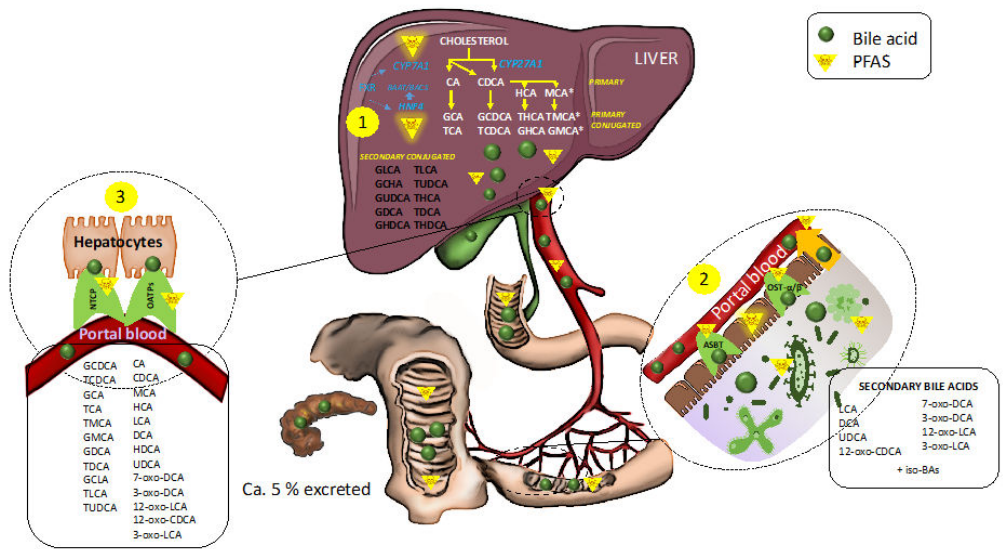
Figure 3. Bile acid biosynthesis and enterohepatic circulation, and the impact of polyfluoroalkyl substances (PFASs) on bile acid (BA) metabolism. (1) In the liver, the classic BA synthesis pathway is initiated by cholesterol 7 α -hydroxylase (CYP7A1) which is downregulated by PFAS. The alternative BA synthesis pathway is initiated by CYP27A1 to synthesize primary bile acids, CA and CDCA, in hepatocytes. CDCA can be further converted to HCA and MCA in the liver. CYP7A1 is downregulated by PFAS. Bile acids are conjugated to the amino acids taurine or glycine before being released into the intestine. HNF4 α , which plays a central role in bile acid conjugation by direct regulation of VLACSR and BAAT, can be suppressed by PFAS. (2) BAs are recovered into portal blood through a combination of passive absorption in the proximal small intestine, active transport via apical bile salt transporter (ASBT) in the distal ileum, and passive absorption in the colon and via organic solute transporter α / β (OST α / β ). Perfluorooctanesulfonic acid (PFOS) can also be transported by ASBT and OST α / β . Furthermore, PFAS can increase the permeability of the gut, thus impacting the passive transport pathway of BAs. In the colon, BAs are also deconjugated by bacterial bile salt hydrolase and are 7 α -dehydroxylated by bacterial 7 α -dehydroxylase to form secondary BAs. PFAS can modify gut microbial composition and thus impact microbial BA formation. (3) BAs are eventually recycled from portal blood back to hepatocytes via Na-taurocholate co-transport peptide (NTCP) and the sodium-independent organic anion transporting polypeptide (OATP). PFASs also utilize the NTCP and OATP transporter. The majority (90–95%) of BAs secreted into the small intestine are actively reabsorbed in the terminal ileum and circulate back to the liver while ca. 5% are excreted via